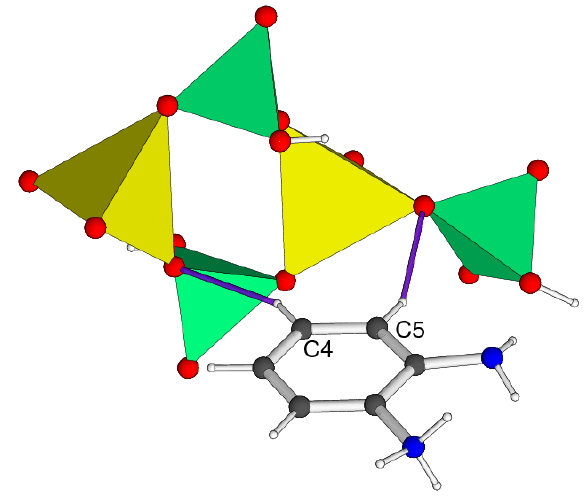
Figure 4. Detail of the structure of 1 showing the possible template-to-framework C–H L O interactions (highlighted in purple). The polyhedral and atom colors are as in Figure